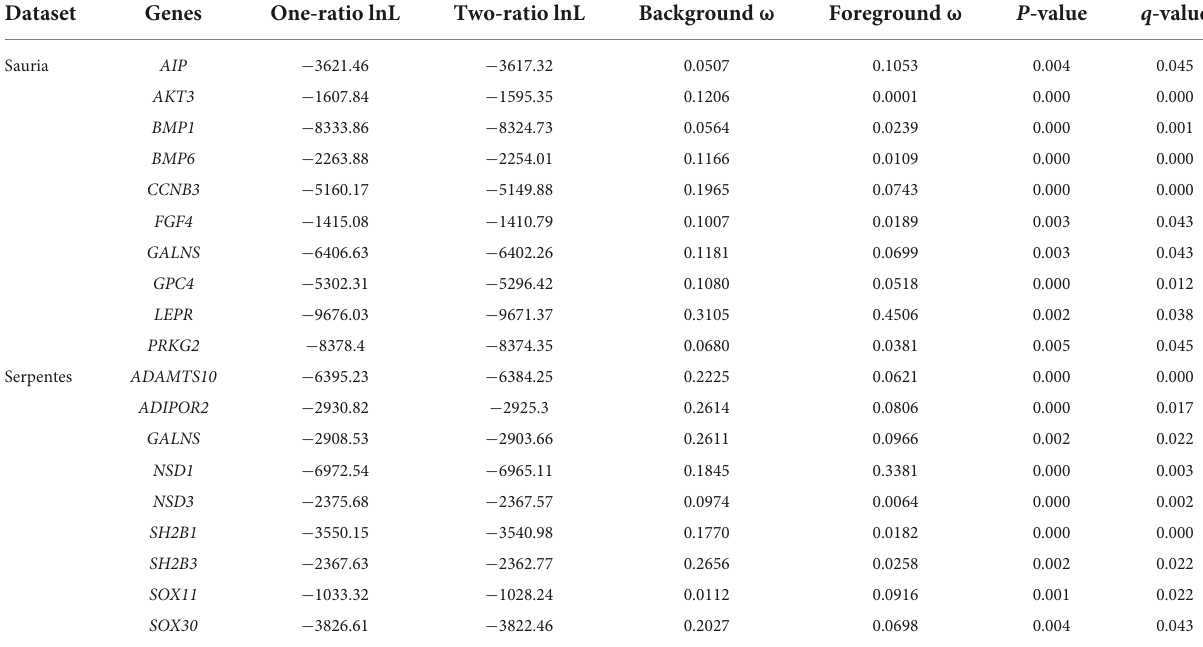
TABLE 1 Genes detected to be under positive selection by branch model (the terminal branches of large-bodied species as unified foreground branch). Dataset